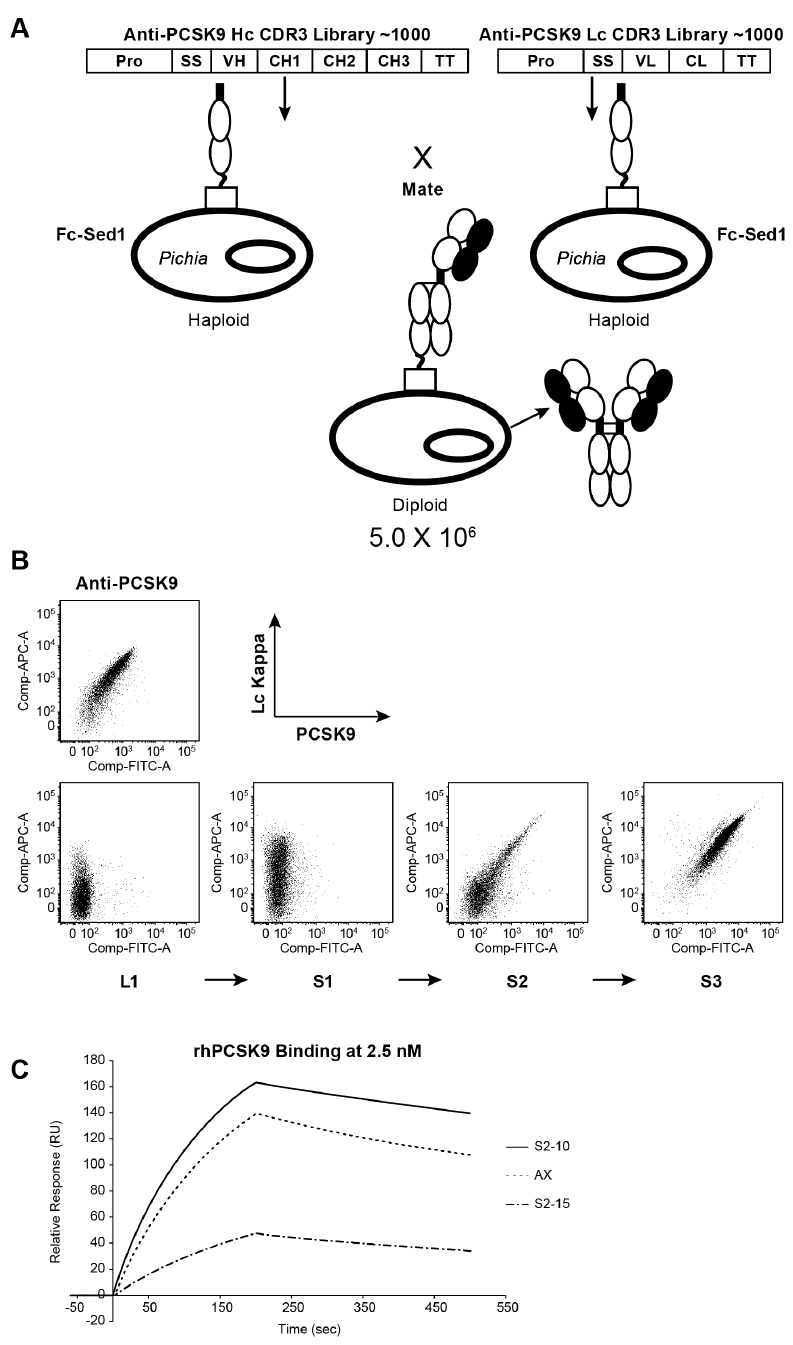
Figure 4. The construction of a proof of principle mating library and the isolation of high affinity, and high expression antigen binders using Fc-Sed1p. A ) Haploid Pichia pastoris strains containing Fc-Sed1p expression cassette were transformed with a library of Anti-PCSK9 Hc or a library of Anti-PCSK9 Lc. Following mating and selection, diploids were cultured to express full length IgG library. Cultures were labeled using 20nM biotinylated human PCSK9 and APC 635 labeled antihuman Kappa. DyeLight 488 labeled Streptavidin was used to detect biotinylated PCSK9. B ) Analysis and enrichment of high affinity anti-PCSK9 binders using three rounds of sequential sorting (S1 > S2 > S3). Known anti-PCSK9 strain co-expressing Fc-Sed1p was labeled as above as a control. C ) Sensograms showing binding and dissociation kinetics of rhPCSK9 to immobilized anti-PCSK9 antibodies. Each anti-PCSK9 antibody lead was captured on the chip to ~ 500 RU followed by analyte injections of wild-type human PCSK9 at concentrations ranging from 0.156–2.5nM. Kinetics for the highest PCSK9 concentration (2.5 nM) is depicted for these antibodies. doi: 10.1371/journal.pone.0070190.g004 PLOS ONE |